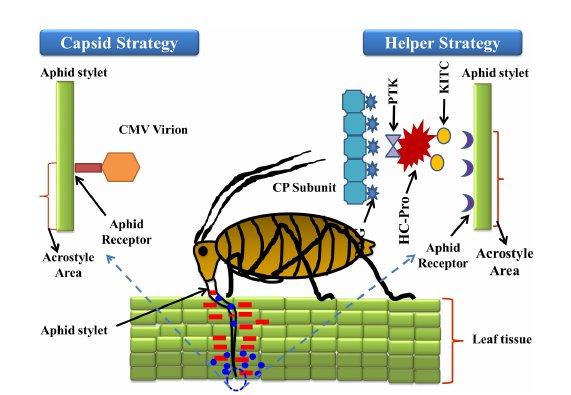
FIGURE1 In the former, coat protein (CP) of virus interact directly with the binding sites (receptors) present in the stylet of aphid; in later, an additional non-structural protein namely HC-Pro (helper component proteinase) induces the binding between CP and aphid receptor component, thus creates a reversible “molecular bridge” that leads to effective infection by the aphid vector. In relation to aphid transmission, HC-Pro N-terminal domain (KITC—Lysine/Isoleucine/Threonine/Cysteine) is involved in specific binding to an aphid’s stylet tip (acrostyle); while it’s C-terminal domain (PTK-Proline/Threonine/Lysine) is